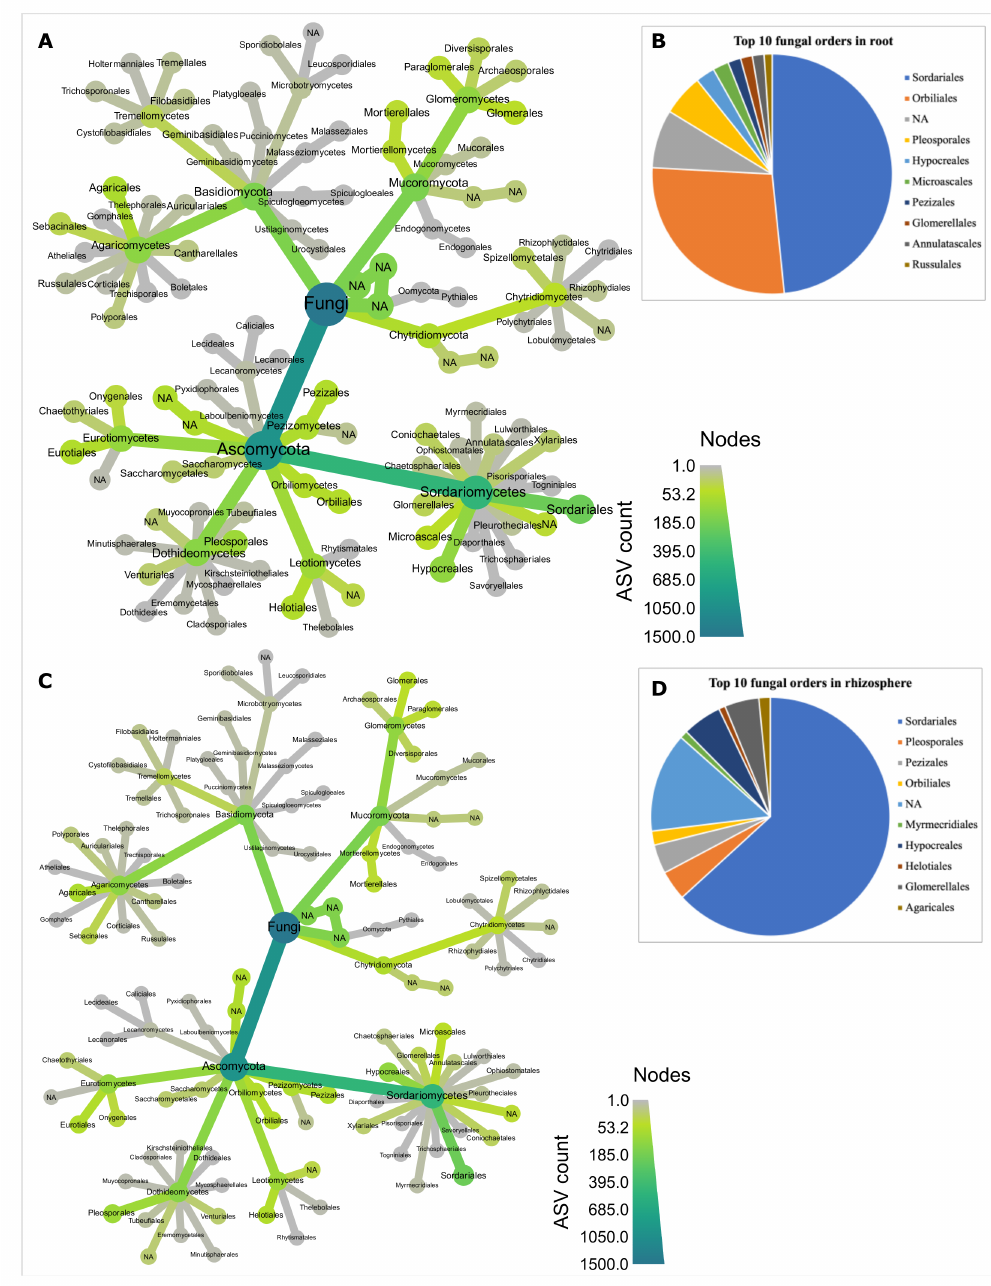
Figure 5. Taxonomic hierarchy (taxmap) and associated observations of ASVs (taxmap) for fungal communities. Taxmap at order level in root ( A ) and relative abundance of top 10 orders in root ( B ). Taxmap at order level in rhizosphere ( C ) and relative abundance of top 10 orders in rhizosphere biotope ( D